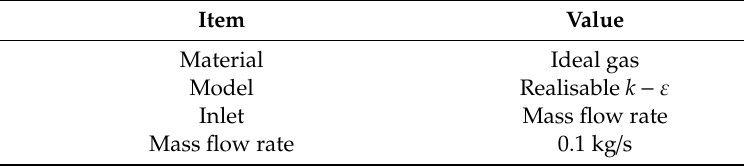
Table 2. Settings of the computational fluid dynamics (CFD) software.